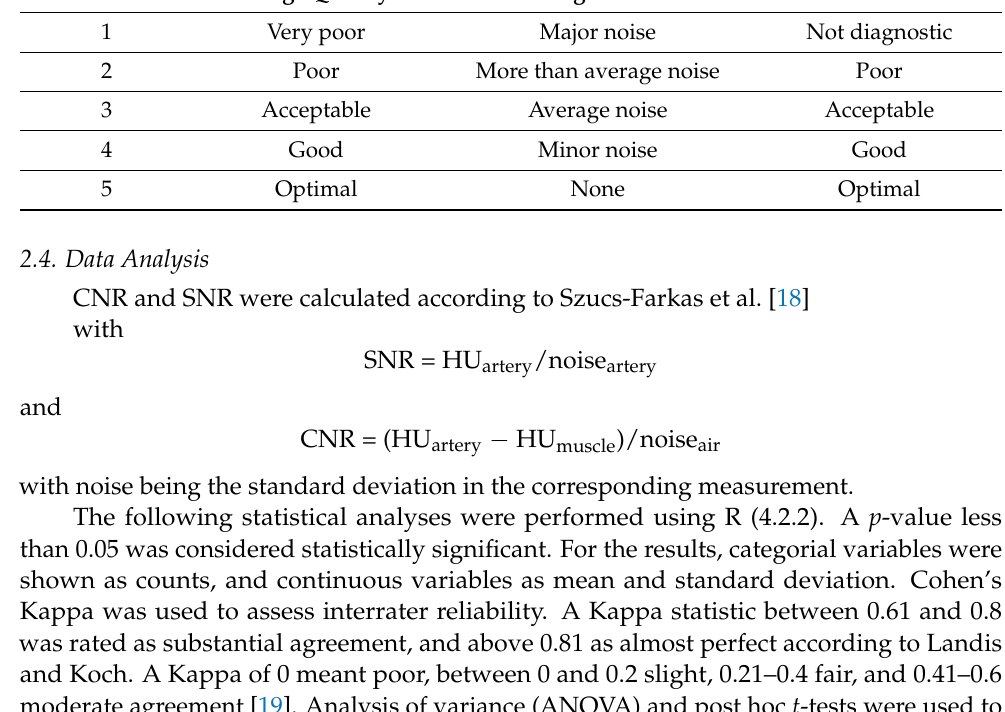
Table 1. Five-point Likert Scale for judging image quality, image noise and vessel contrast. Image Quality Image